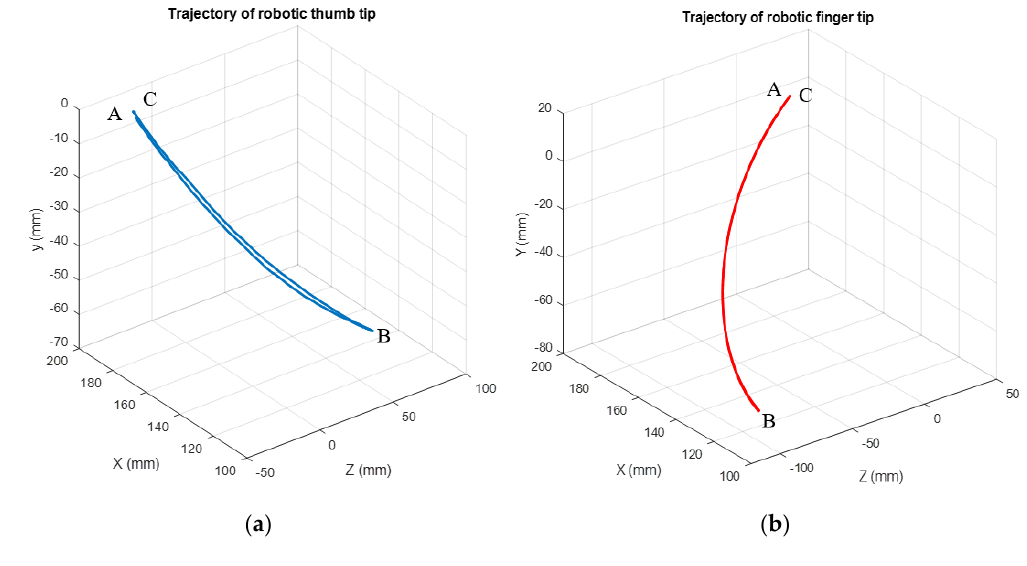
Figure 11. Fingertip trajectories: ( a ) RT; ( b ) RF. Table 5. Bimanual manipulation assist test with the developed extra robotic fingers.